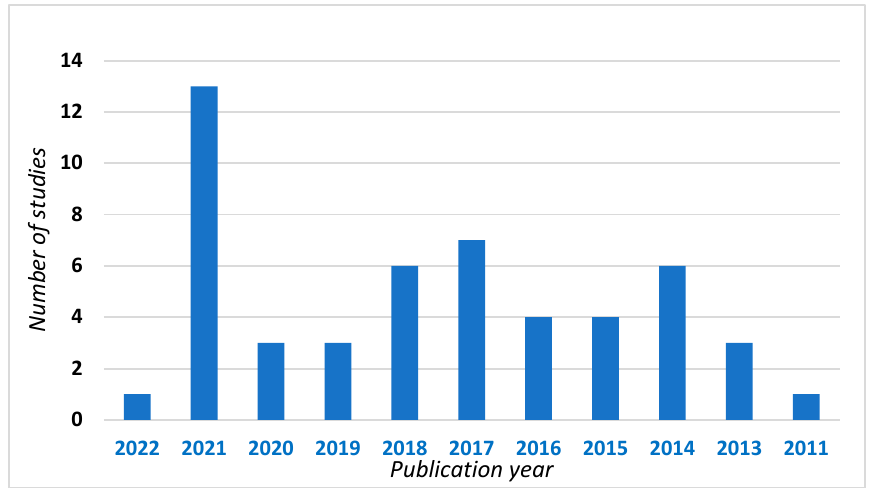
Figure 1. Studies included in this review divided according to year of publication. Table 1. Non-invasive prenatal diagnosis of chromosomal aneuploidies studies included in the